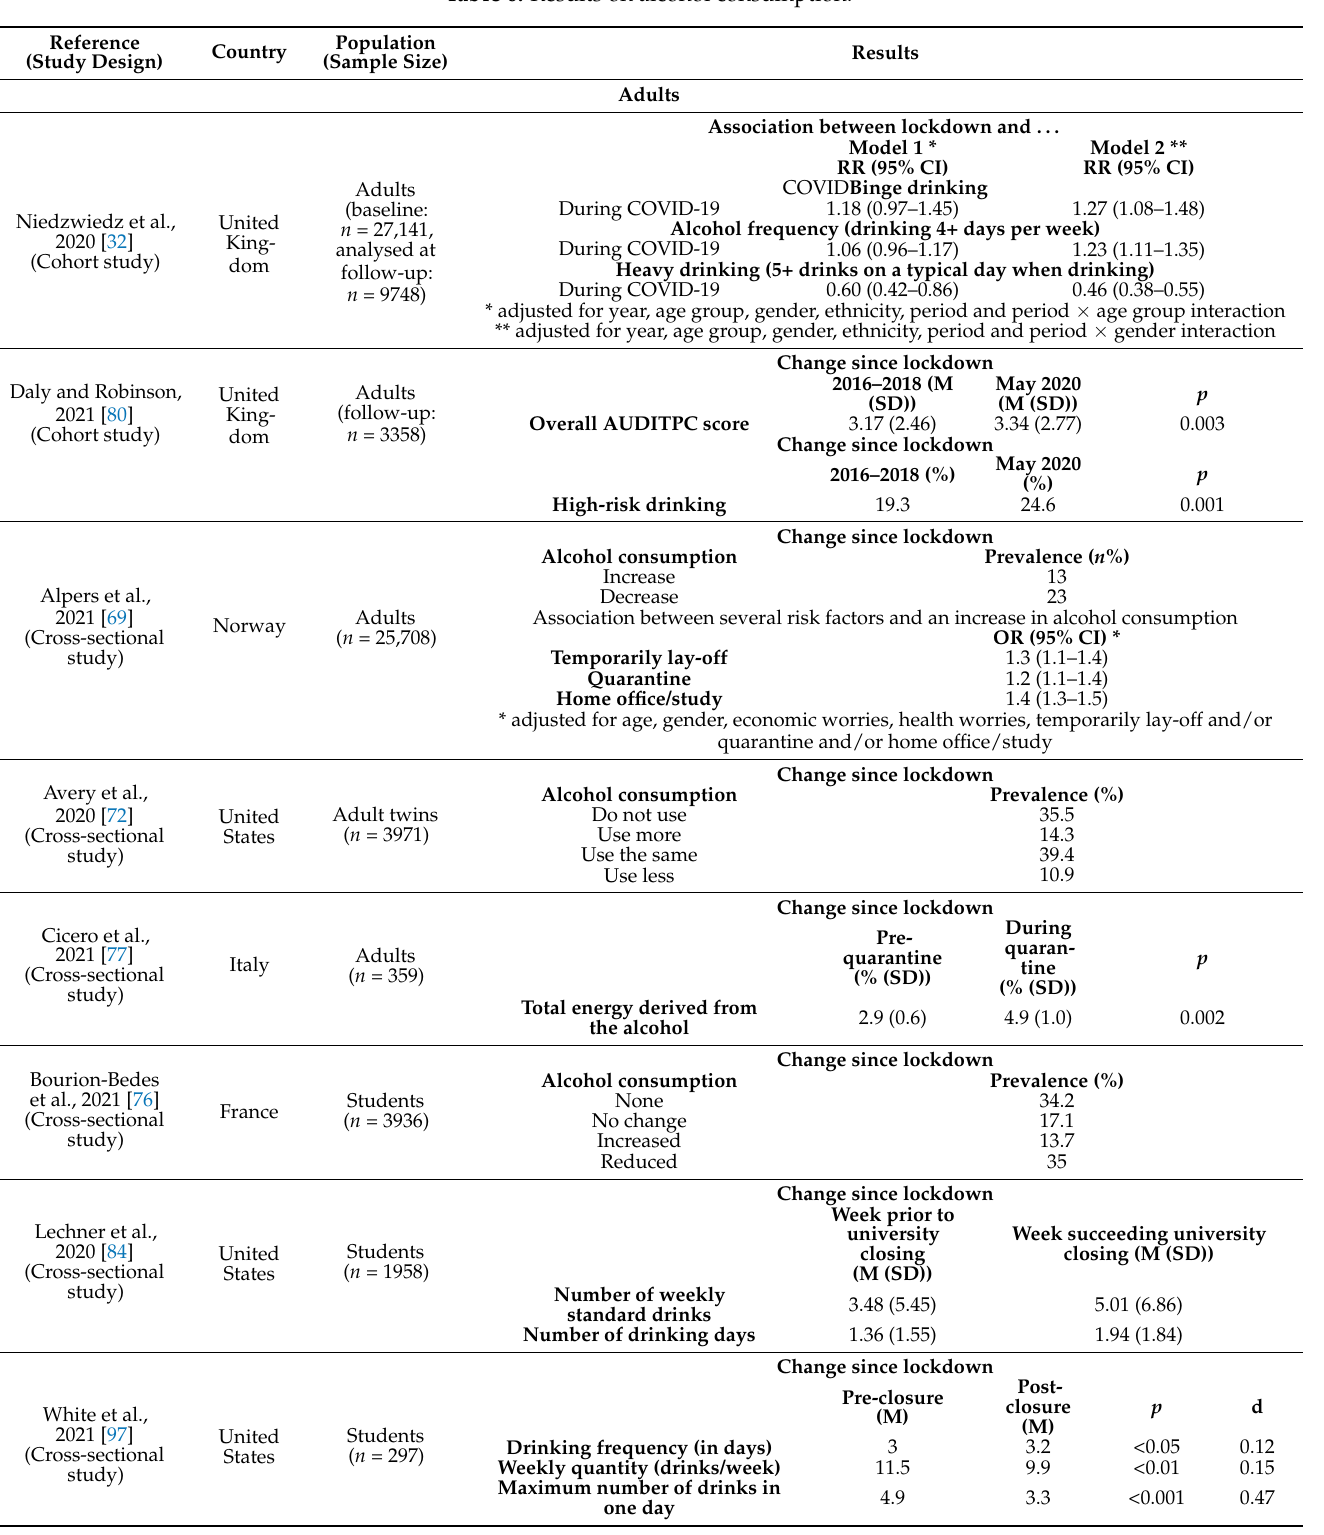
Table 6. Results on alcohol